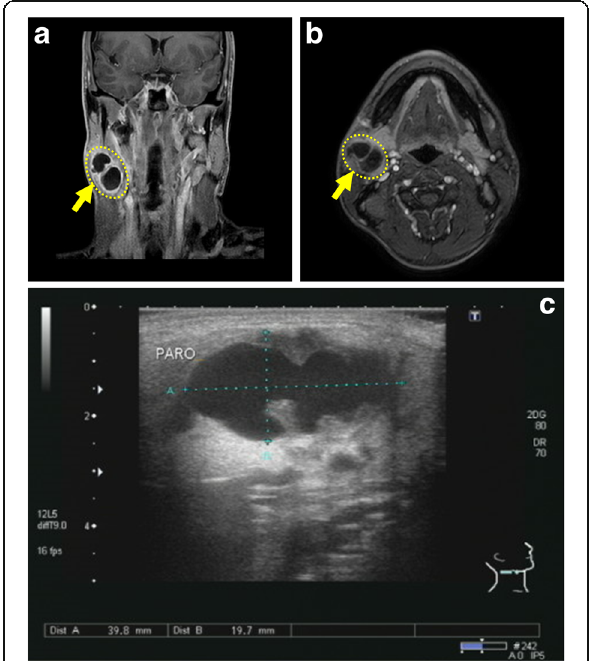
Fig. 1 An inflammatory cyst within the submandibular gland. Coronal ( a ) or axial ( b ) T 2 -weighted MRI images of the head and neck demonstrating the existence of a cyst within the right submandibular gland (yellow arrows). Ultrasonic imaging of the inflamed submandibular gland ( c ) showed the inflammatory cyst as a black hole with sharp borders, measured 39.8 mm×19.7 mm in